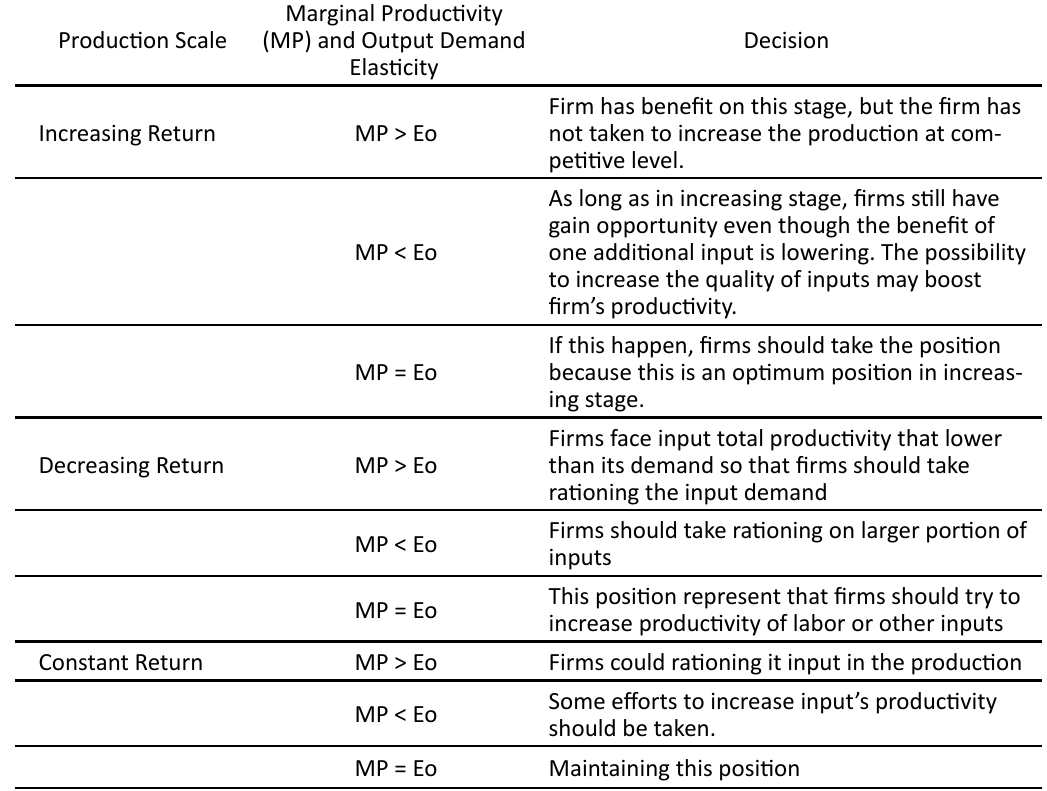
Table 3: Firms Behavior on Production